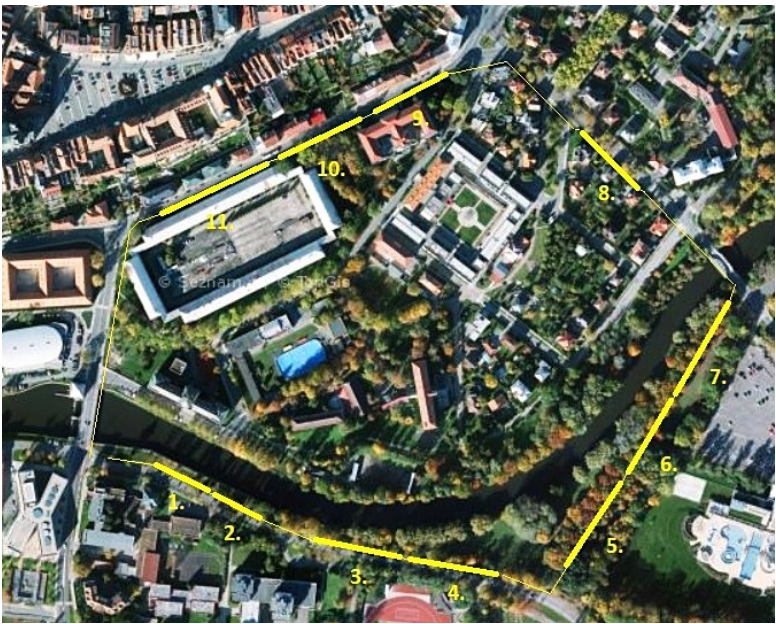
Figure 1. Walking route. Sections 1–11, where walking speed was measured, are indicated.